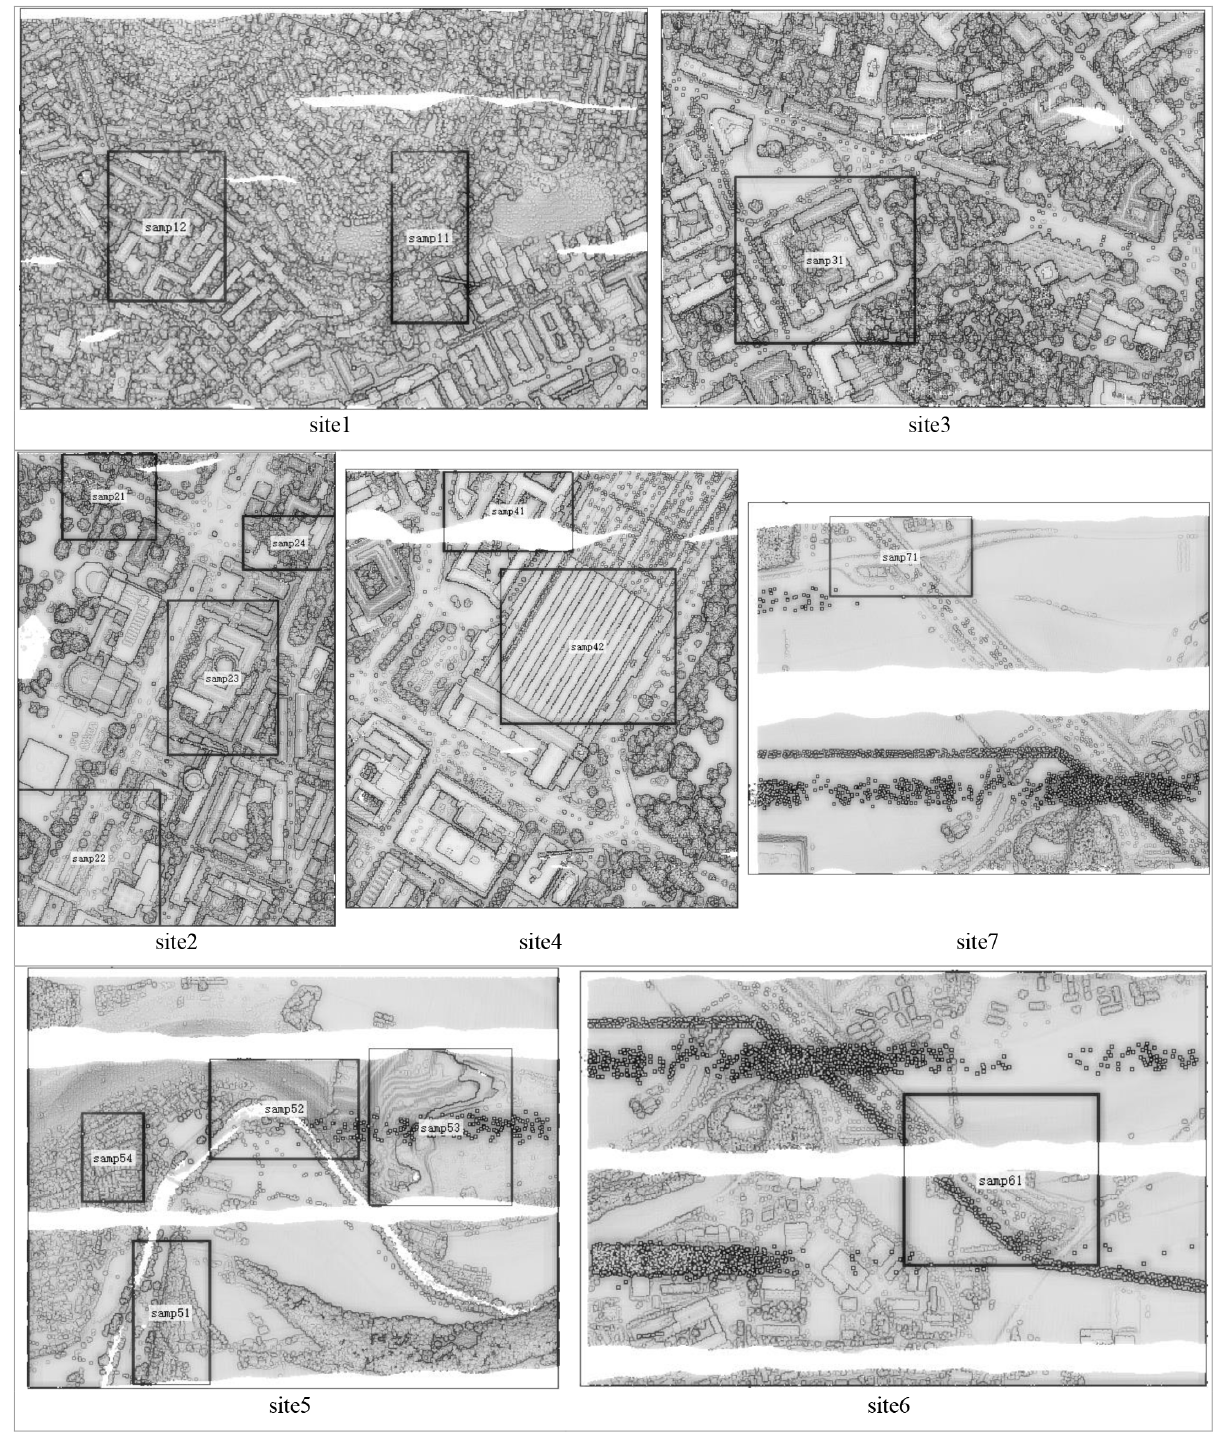
Figure 5. The locations of the experimental samples on the corresponding sites.